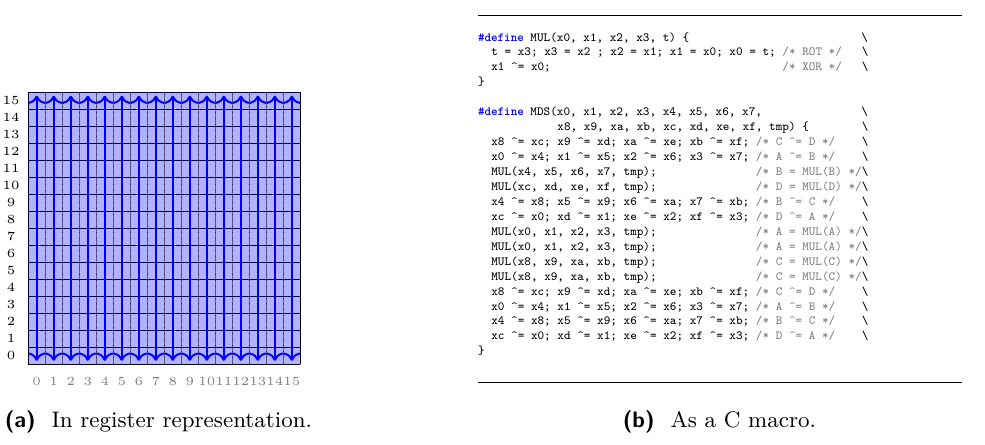
by dashed brown ones. 1